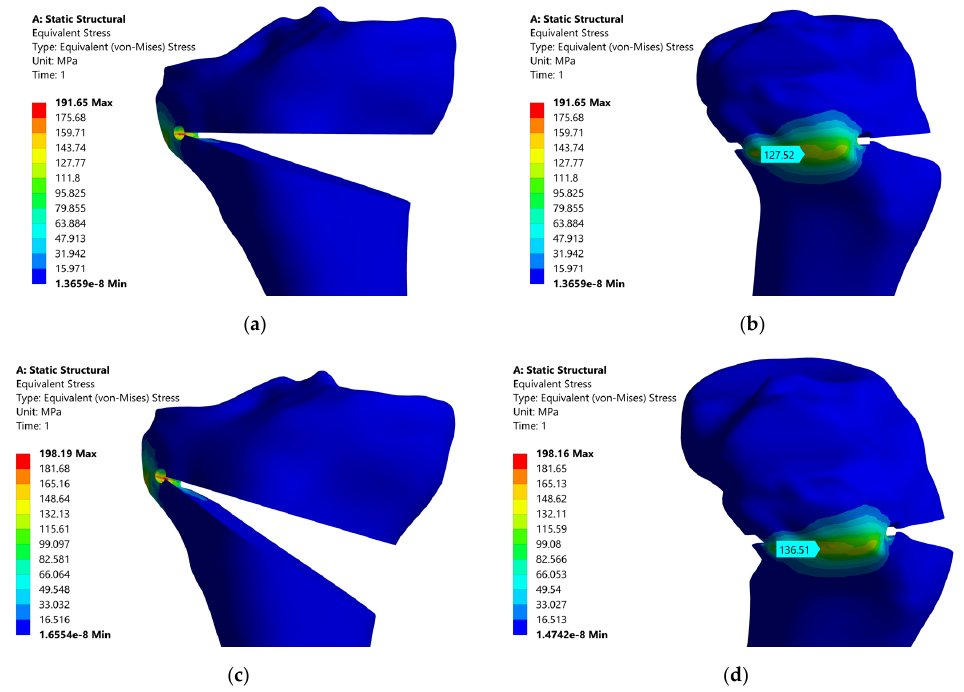
Figure 9. Equivalent von Mises stress in the CORA area—for X 1 = 40 mm, X 2 = 14 degrees, the inner surface ( a ) and the outer surface ( b ) and for X 1 = 50 mm, X 2 = 14 degrees the inner surface ( c ) and the outer surface ( d ).